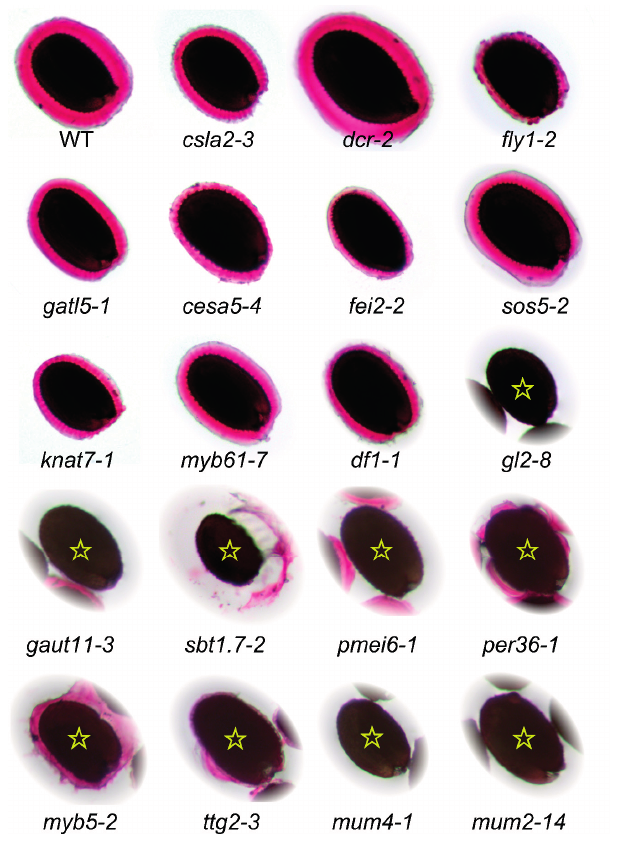
Figure 4. Analysis of RR staining phenotypes of WT and 19 known mucilage mutants. Seeds, grown under continuous light, were gently mixed with water for 5 min in a 24-well plate. The adherent mucilage was stained with 0.01% RR for 5 min. For the last nine mutants (marked with a star), most seeds float in the center of each well.